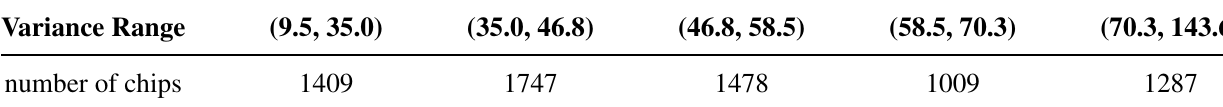
Table 11. Number of chips in each range.